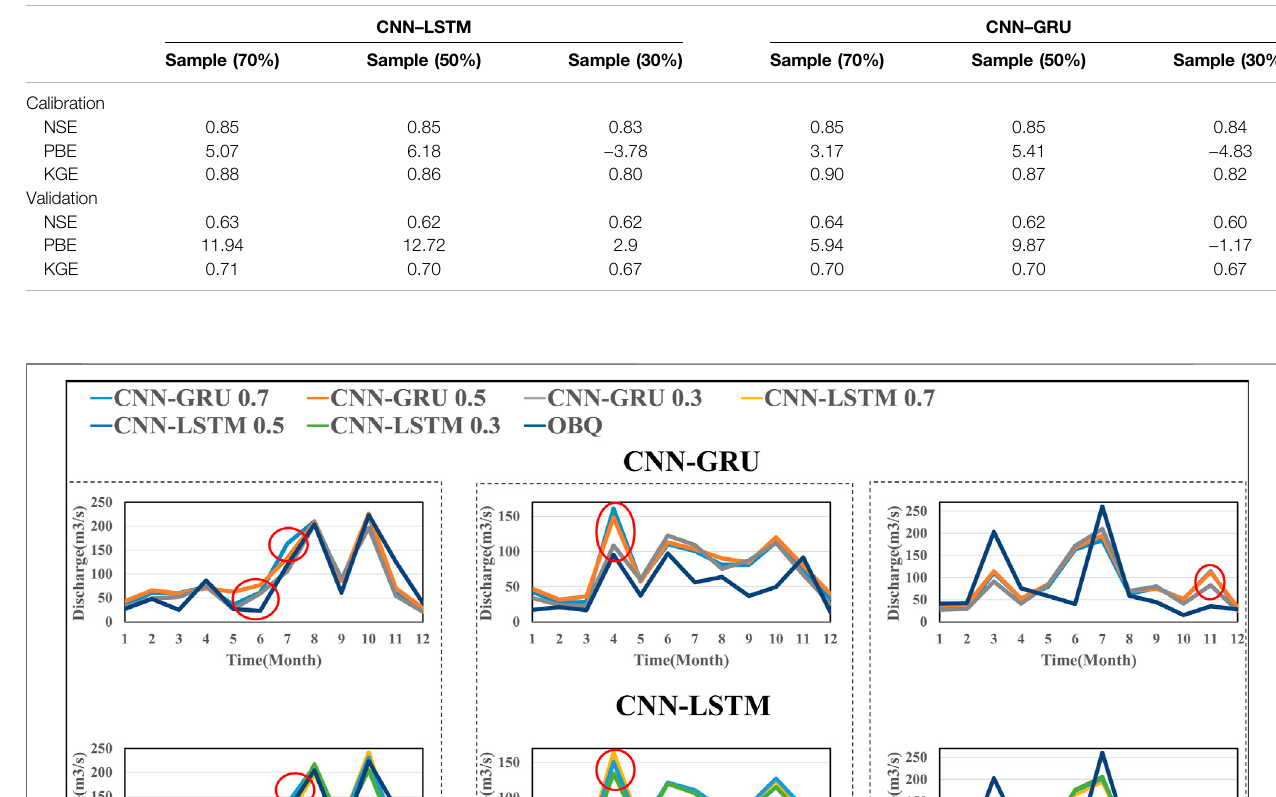
TABLE 5 | Performance of deep learning models under different size of training samples.